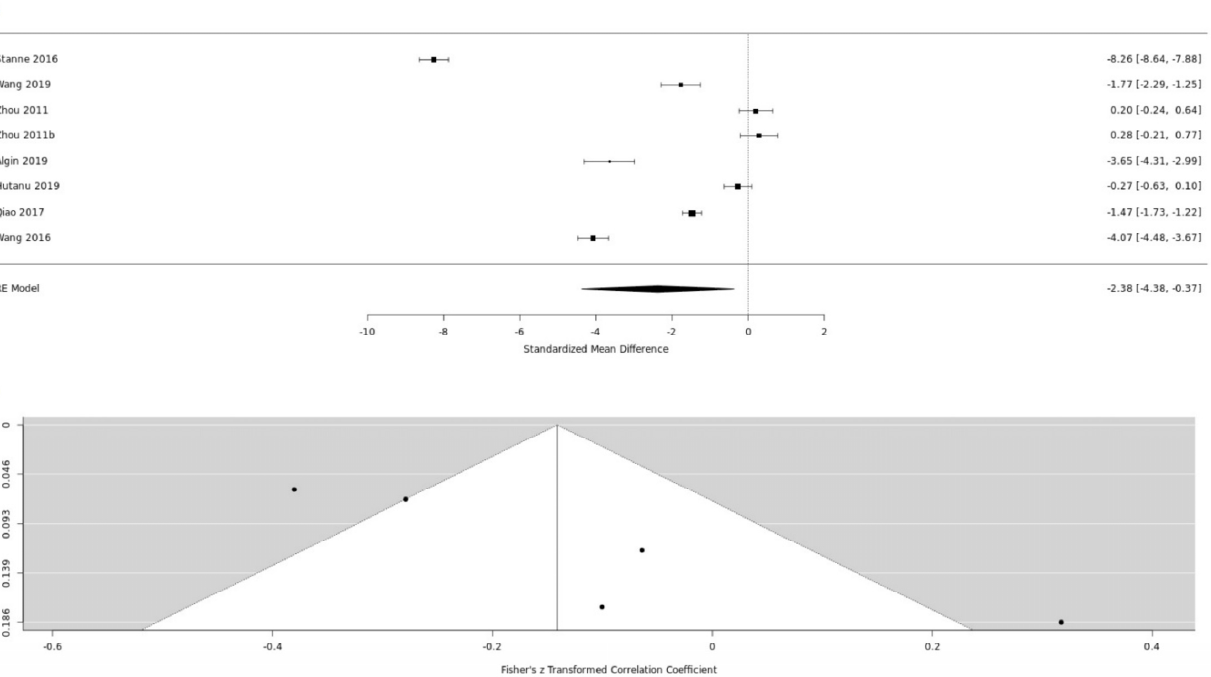
Figure 7. Serum BDNF in stroke patients versus controls up. forest and down. funnel plot.